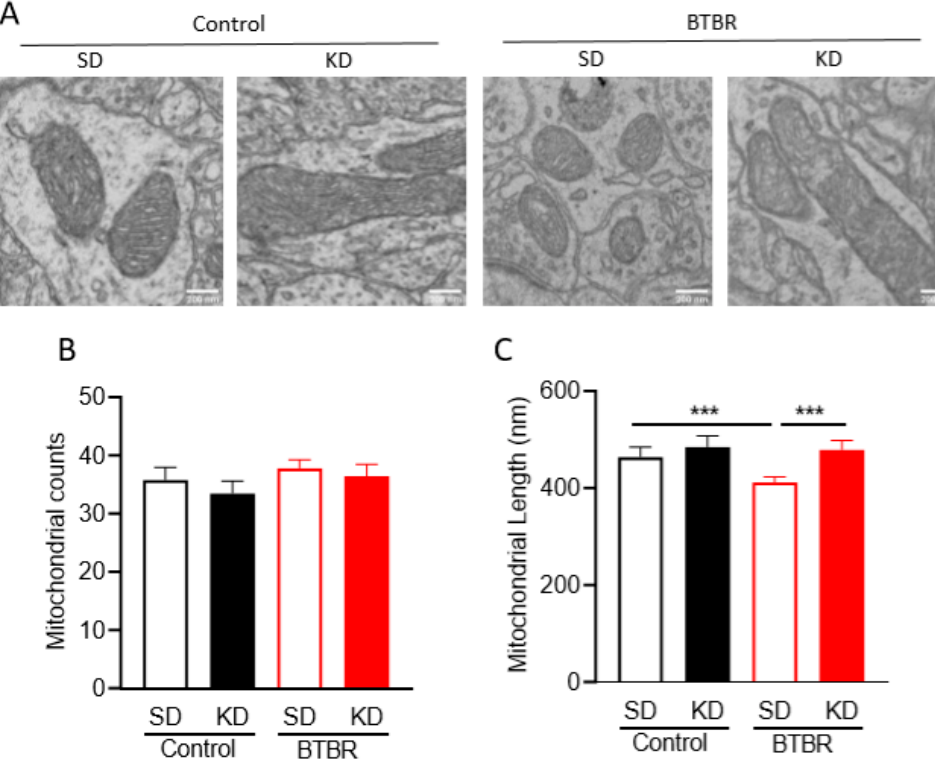
Figure 3. Transmission electron microscopy (TEM) data of neocortical tissue sections from BTBR and control mice. ( A ) Representative TEM images from control and BTBR mice fed SD or KD. Scale bars represents 200nm. ( B ) Mitochondrial counts from micrographs of neocortical tissue sections from control and BTBR mice with/without the KD. ( C ) Mitochondrial length (nm) in TEM micrographs. Data are shown as mean ± SEM, n = 3 per group. Data were analyzed by two-way ANOVA. The significant differences between groups revealed by the post-hoc analysis are presented as *** p < 0.001.